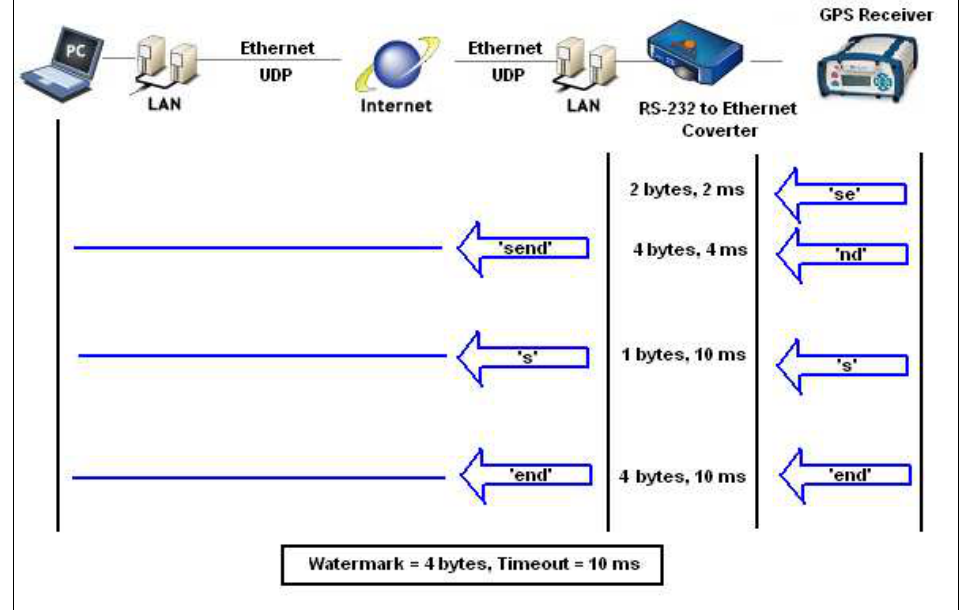
Figure 10. UDP Data Transfer Sequence (based upon [15]).